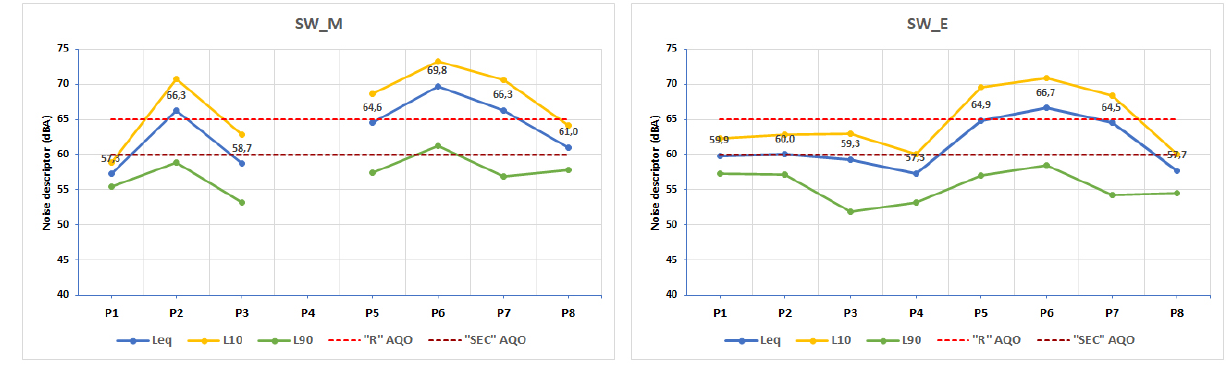
Figure 7: Main noise descriptors and legal acoustic quality objectives during the morning (SW_M) and evening (SW_E) soundwalks at path stops (P1 to